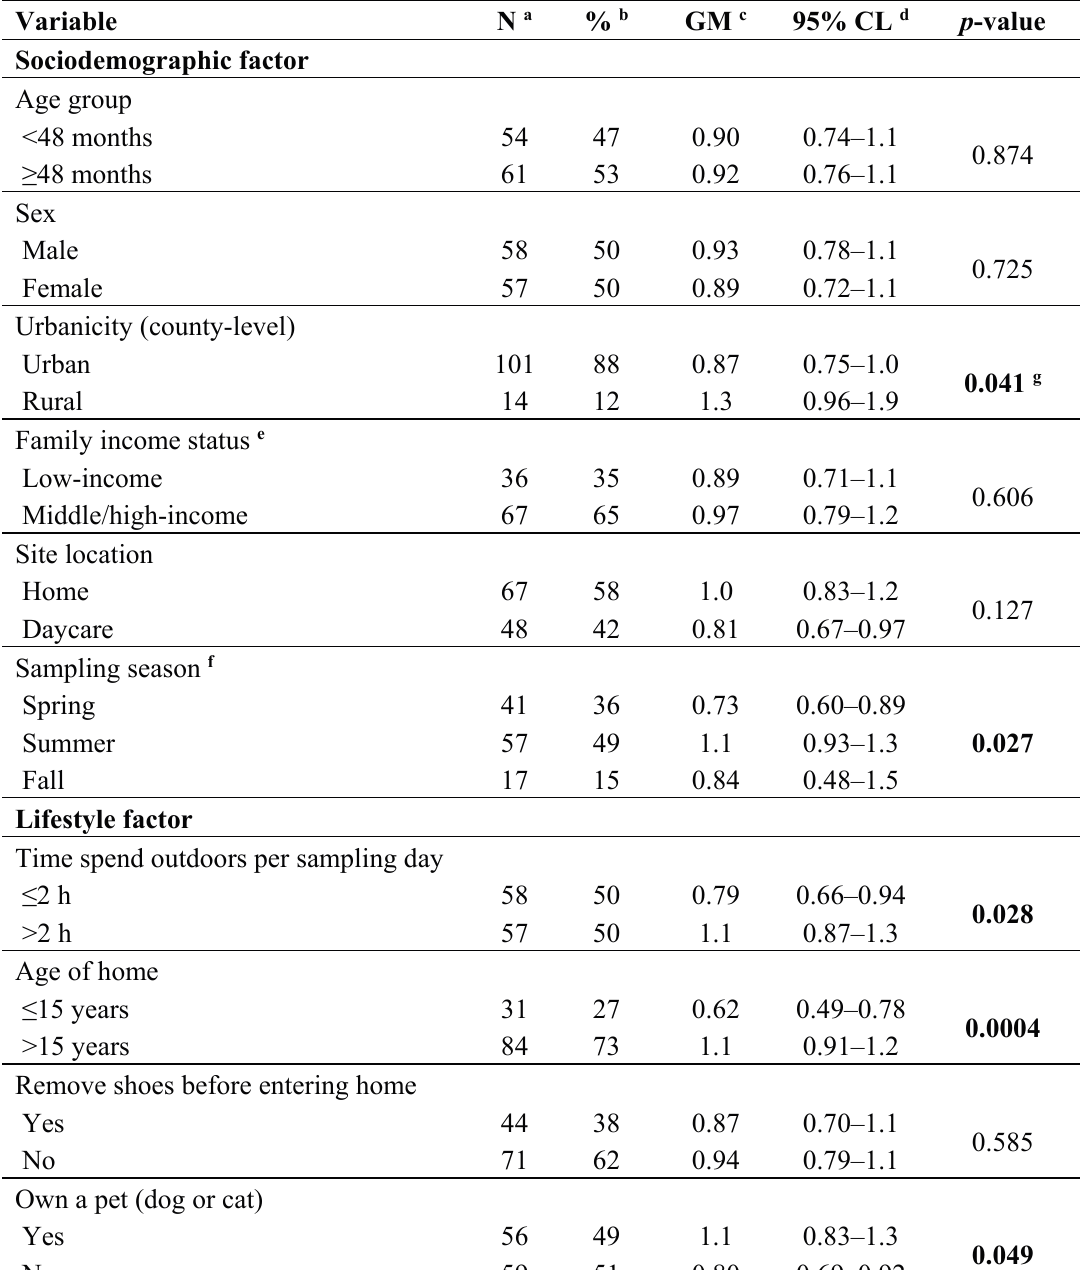
Table 2. Urinary PCP levels (ng/mL) in all children by sociodemographic or lifestyle